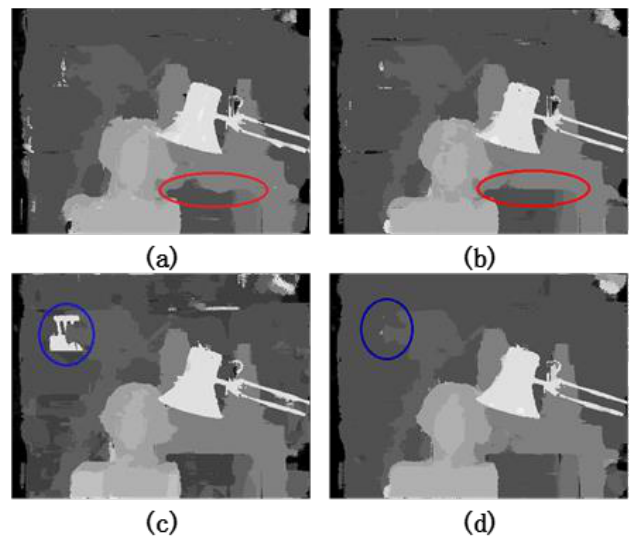
Figure 2. Initial disparity maps based on different matching costs for Tsukuba. ( a ) Absolute difference in image gradients; ( b ) proposed enhanced image gradients-based matching cost; ( c ) traditional census transform-based matching cost; ( d ) proposed improved census transform-based matching cost.